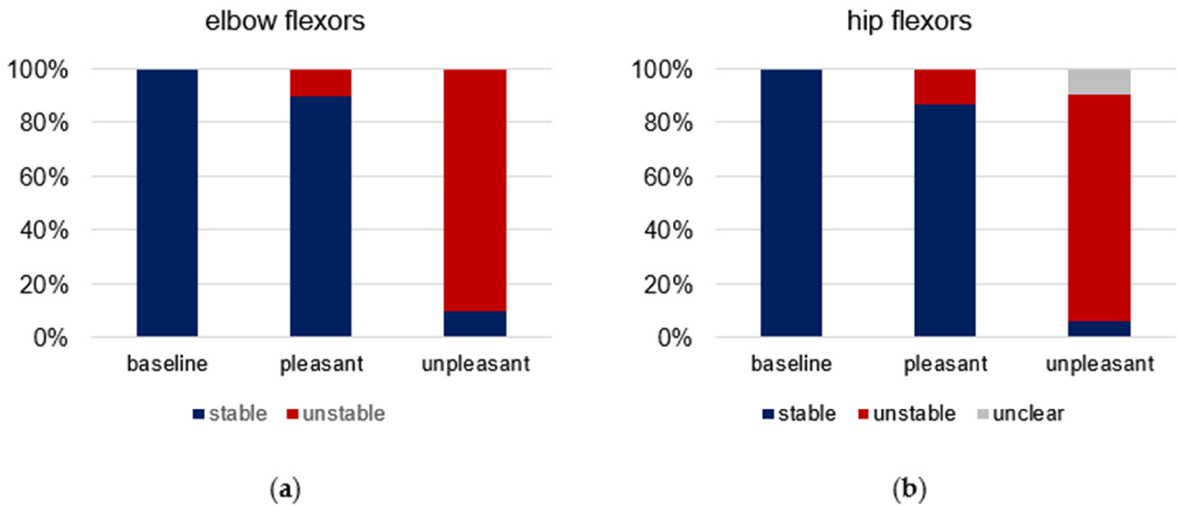
Figure 2. Rating of manual muscle tests (MMT) by the tester. Displayed are the relative shares of the qualitative rating of all MMTs (stable = blue, unstable = red, unclear = grey) regarding baseline (elbow: n = 19, hip: n = 21), pleasant (elbow: n = 29, hip: n = 30) and unpleasant (elbow: n = 30, hip: n = 32) imagery for ( a ) elbow and ( b ) hip flexors.